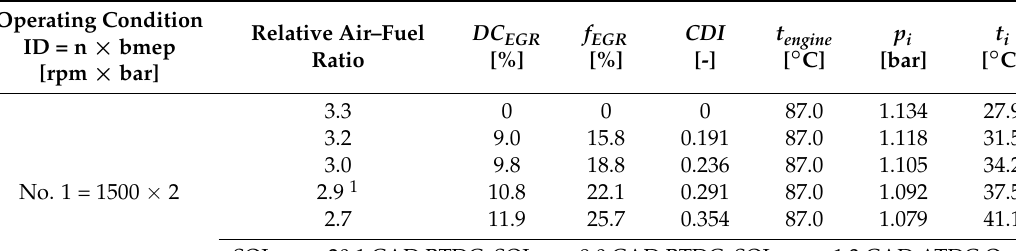
Figure 2. Example of in-cylinder pressure diagram, curve of pressure first derivative and related parameters. Table 2. Schedule of experimental activities (High Pressure (HP) Exhaust Gas Recirculation (EGR) trade-off, operating conditions No. 1 and No. 2).